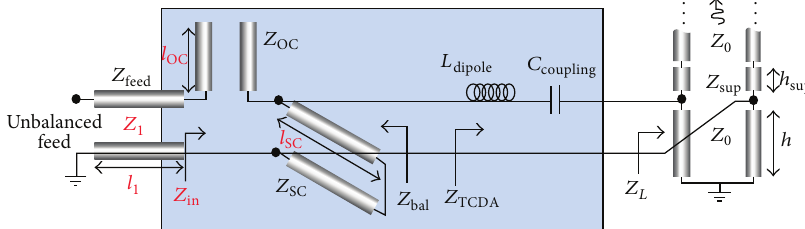
Figure 19: Simplified Marchand balun equivalent circuit (see [48]).